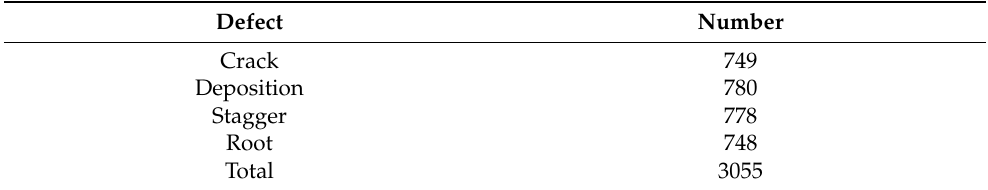
Table 1. Distribution of defect labels.